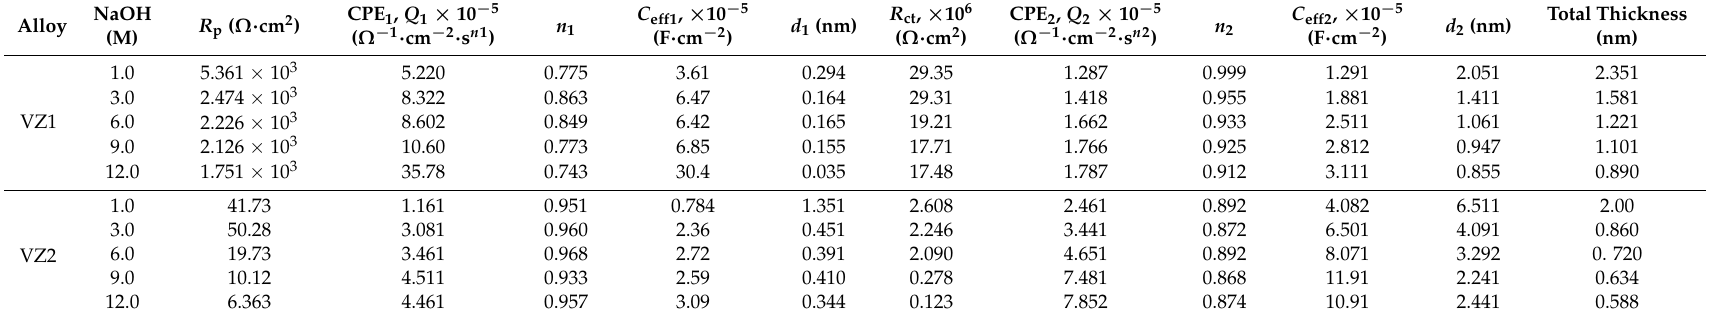
Table 1. Equivalent circuit parameters for the spontaneously formed passive film on VZ1 and VZ2 alloys as a function of NaOH concentration at 27 ◦ C.